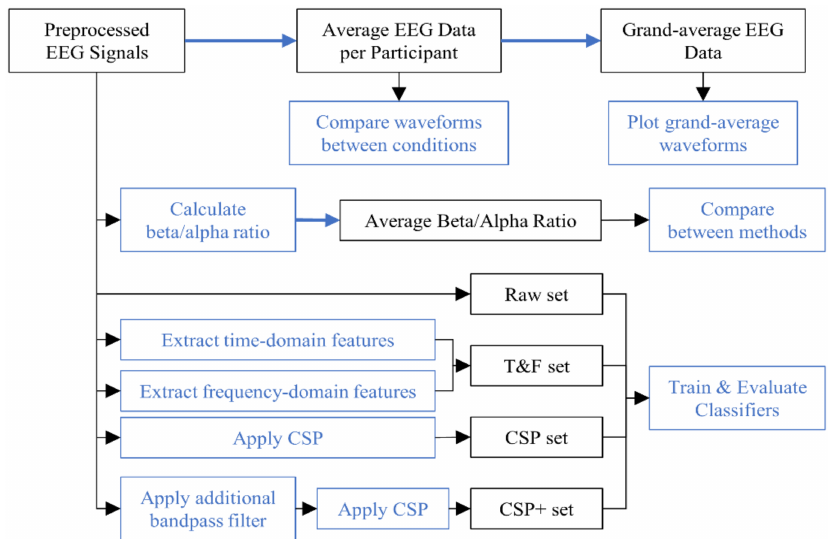
Figure 4. Overall EEG data processing. The black outlined boxes represent data while blue outlined boxes represent processes. Bold blue arrows represent